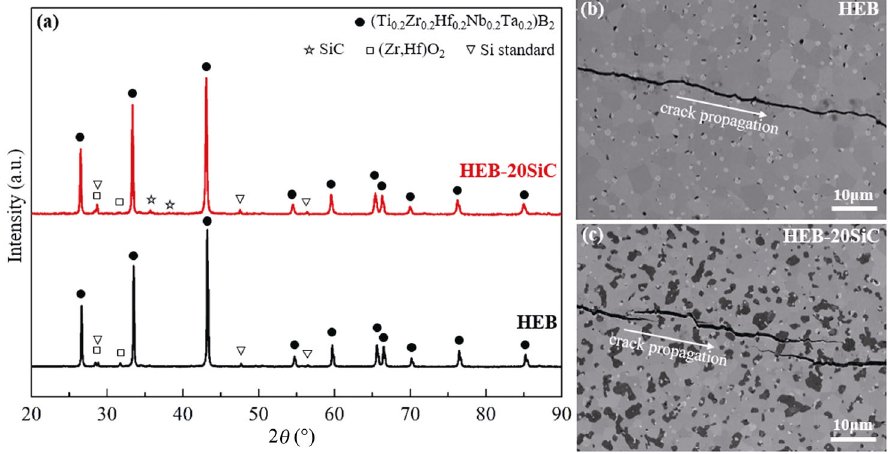
Fig. 1 XRD patterns and SEM morphology of the hot-pressed